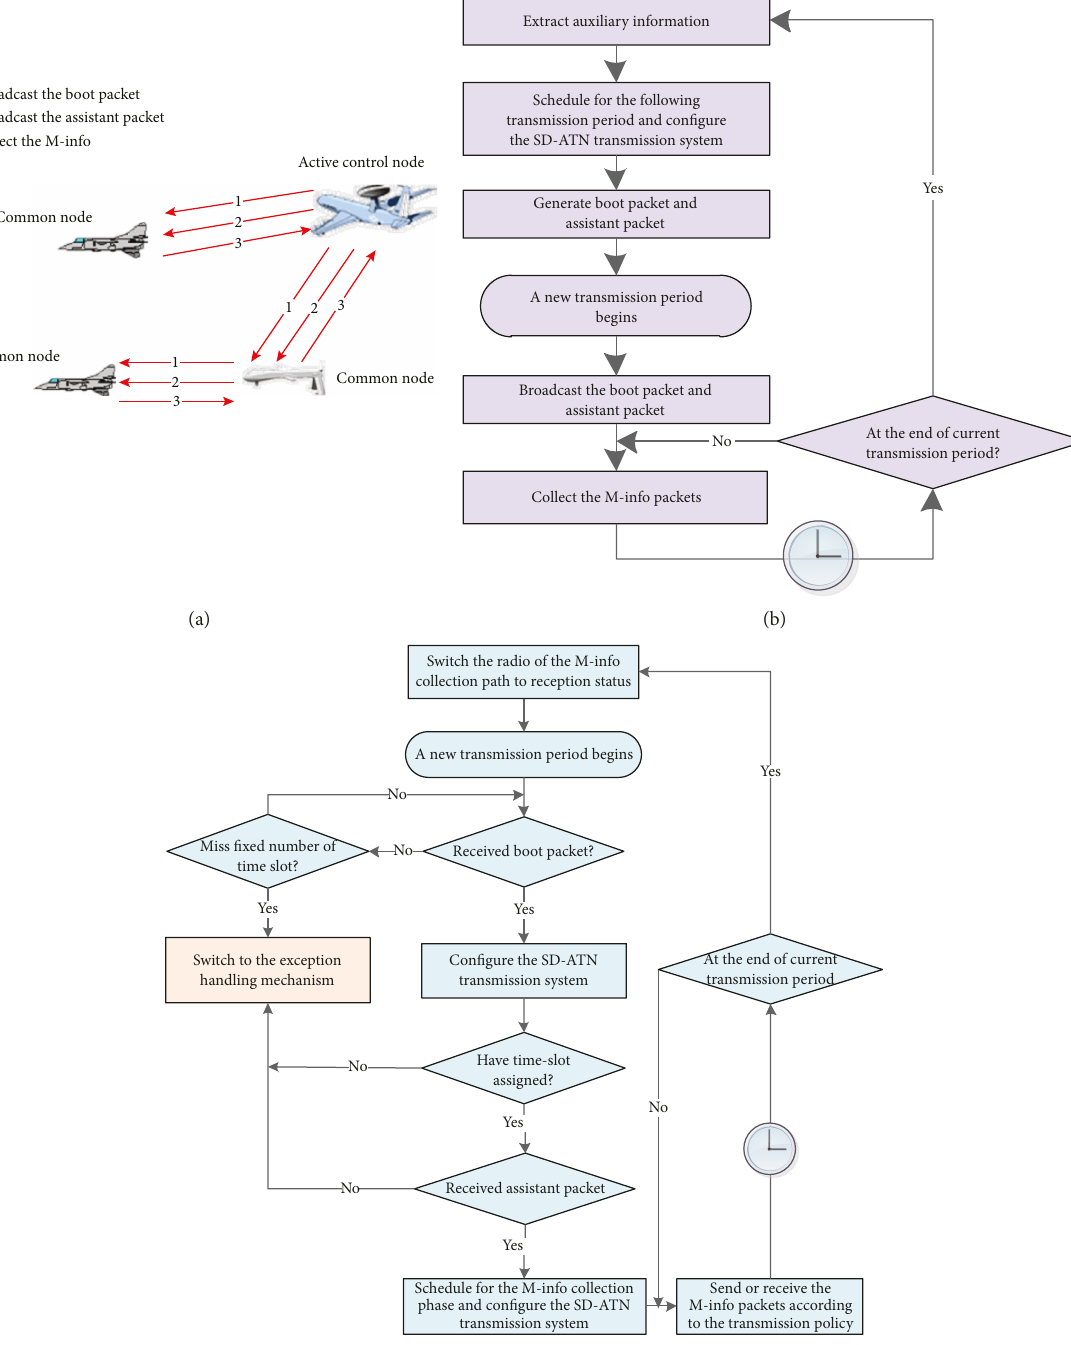
Figure 8: Operation details of the MCP-SD-ATN. (a) General operations. (b) Operation details of the active control node. (c) Operation details of the common